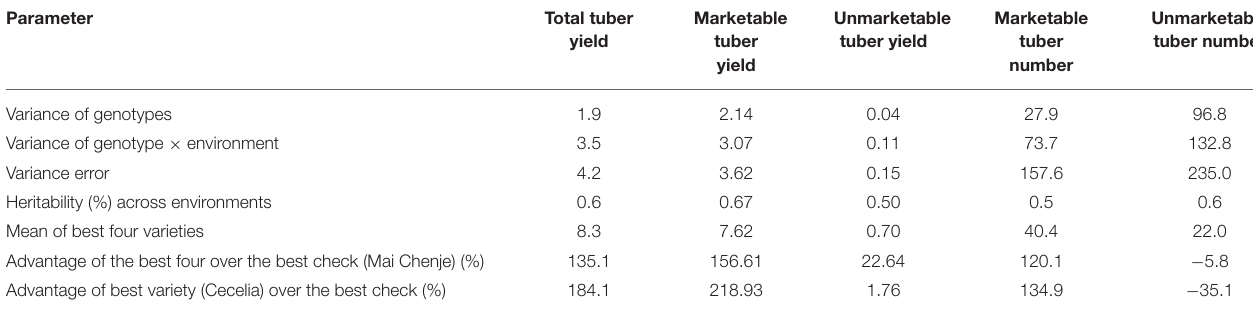
TABLE 3 | Variance components, heritability estimates, and relative advantage of the better varieties over the best check.